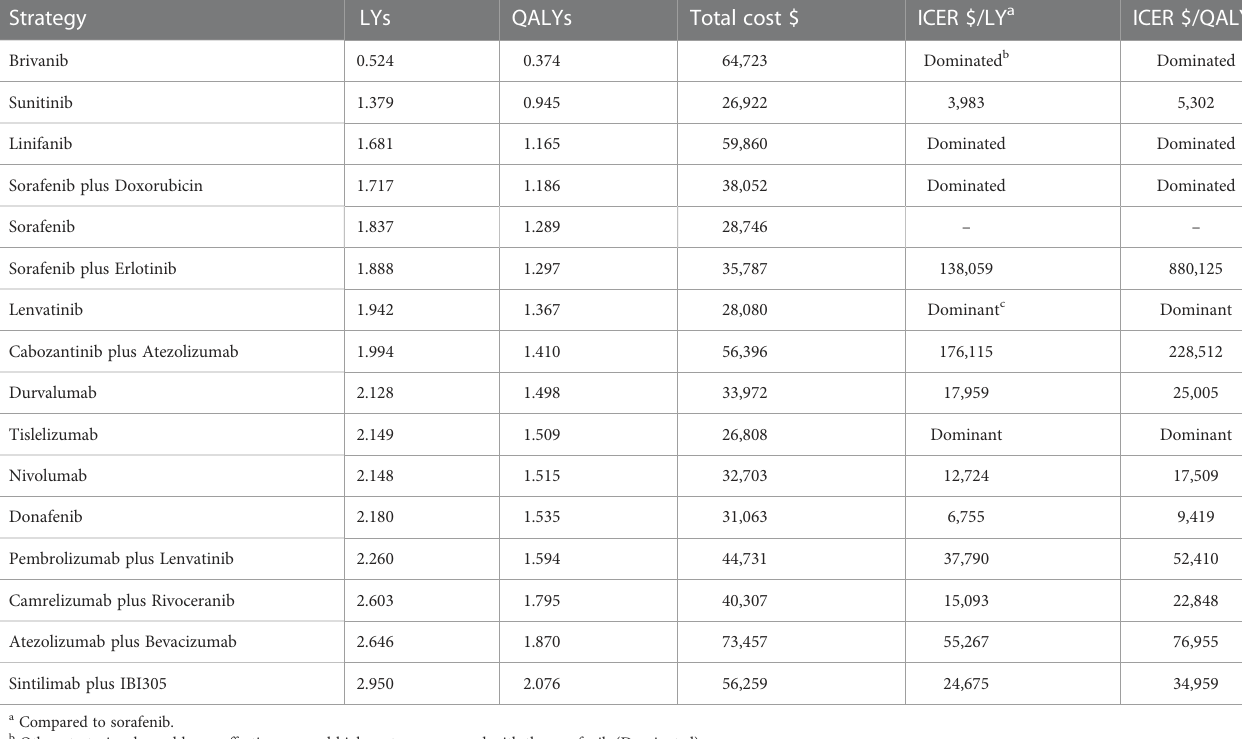
TABLE 2 Baseline